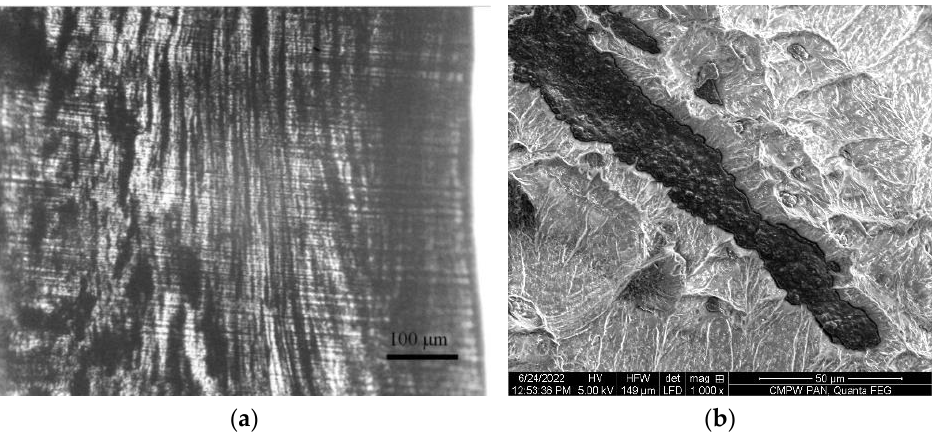
Figure 7. Images of the longitudinal section of the filament with the CB content φ = 2.5 vol%: ( a ) optical microscopy, ( b ) SEM.